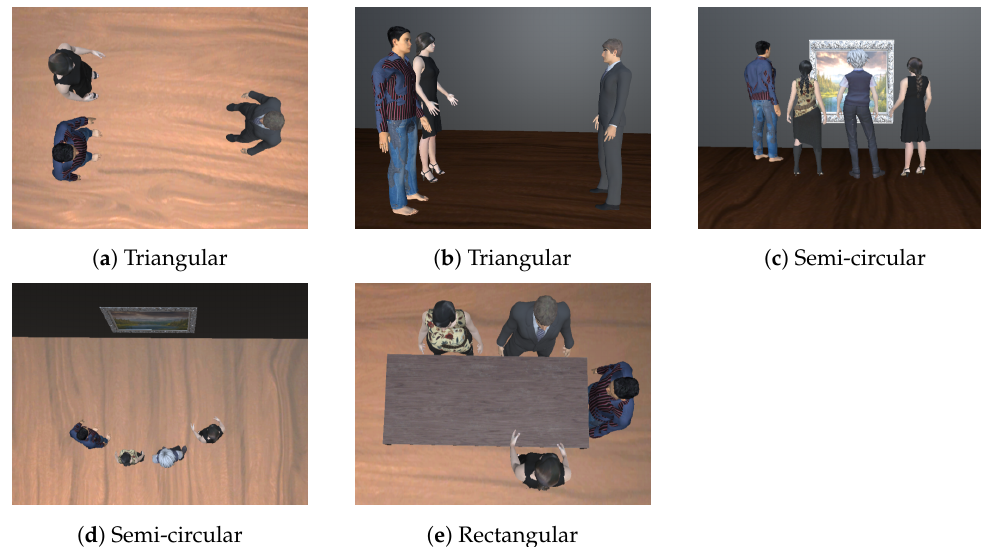
Figure 3. ( a , c , e ) present the constraint-based formations. ( a , b ) represent the triangular formation. ( a ) presents the top view whereas ( b ) presents the ego-centric view. ( c , d ) present the semi-circular formation, ( c ) the ego-centric view, and ( d ) the top